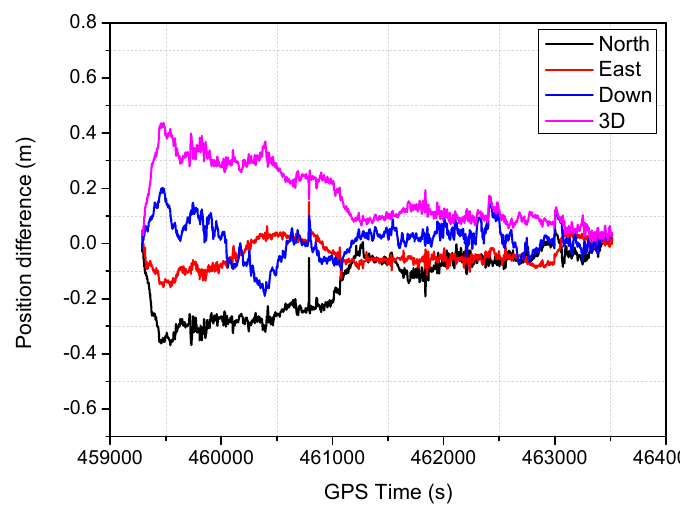
Figure 7. Position difference from the troposphere-constraint fixed PPP/INS with adaptive R.